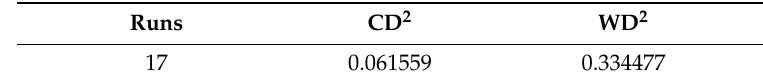
Table 4. Squared values of centered L2-discreapncy (CD 2 ) and wrap-around L2-discrepancy (WD 2 ) of the U 17 (17 8 ).